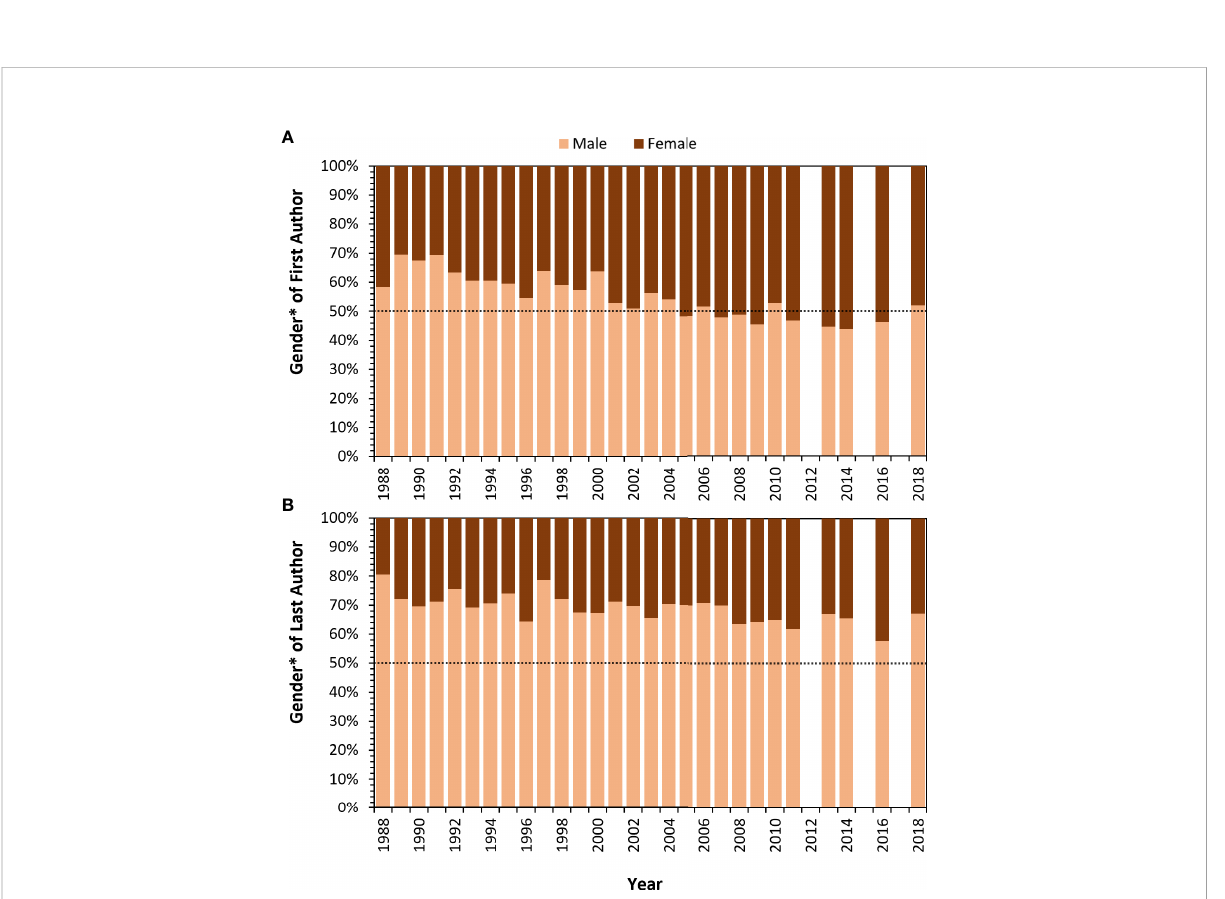
FIGURE 4 Gender* representation of fi rst (A) and last (B) authors for abstracts presented at the International Sea Turtle Symposium as determined through probabilistic inferences from the authors fi rst name. We use the term gender* (with an asterix) as we only distinguish between male or female. We acknowledge that gender is not binary, and the gender* inferred by an author ’ s name may not match the author ’ s self-identi fi ed gender. The black line highlights the 50%